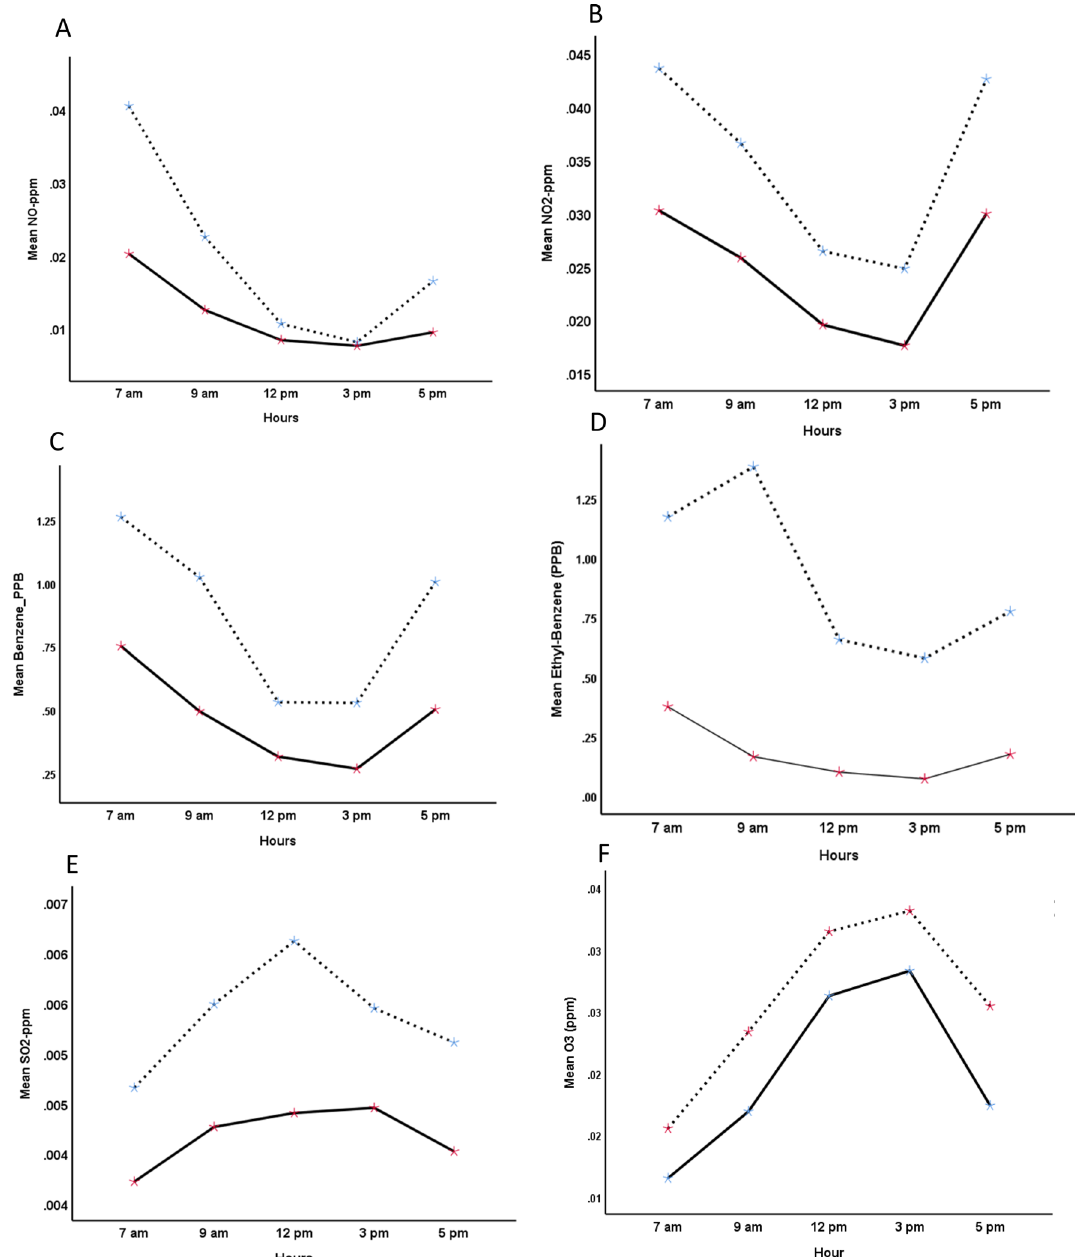
Figure 4. Distribution of important gaseous pollutants across various hours of the day in summer and winter months in Kuwait (Latitude range 28.30–30.00 N). Dotted line represent summer season (May to September) and solid line represent winter season (October to February). A : Nitric oxide (NO); B : Nitrogen dioxide (NO 2 ); C : Benzene; D : Ethyl-benzene; E : Sulfur dioxide (SO 2 ); F : Ozone (O 3 ). Data are mean of the four stations for four years. Benzene and ethyl-benzene are in PPB, all other pollutants are in